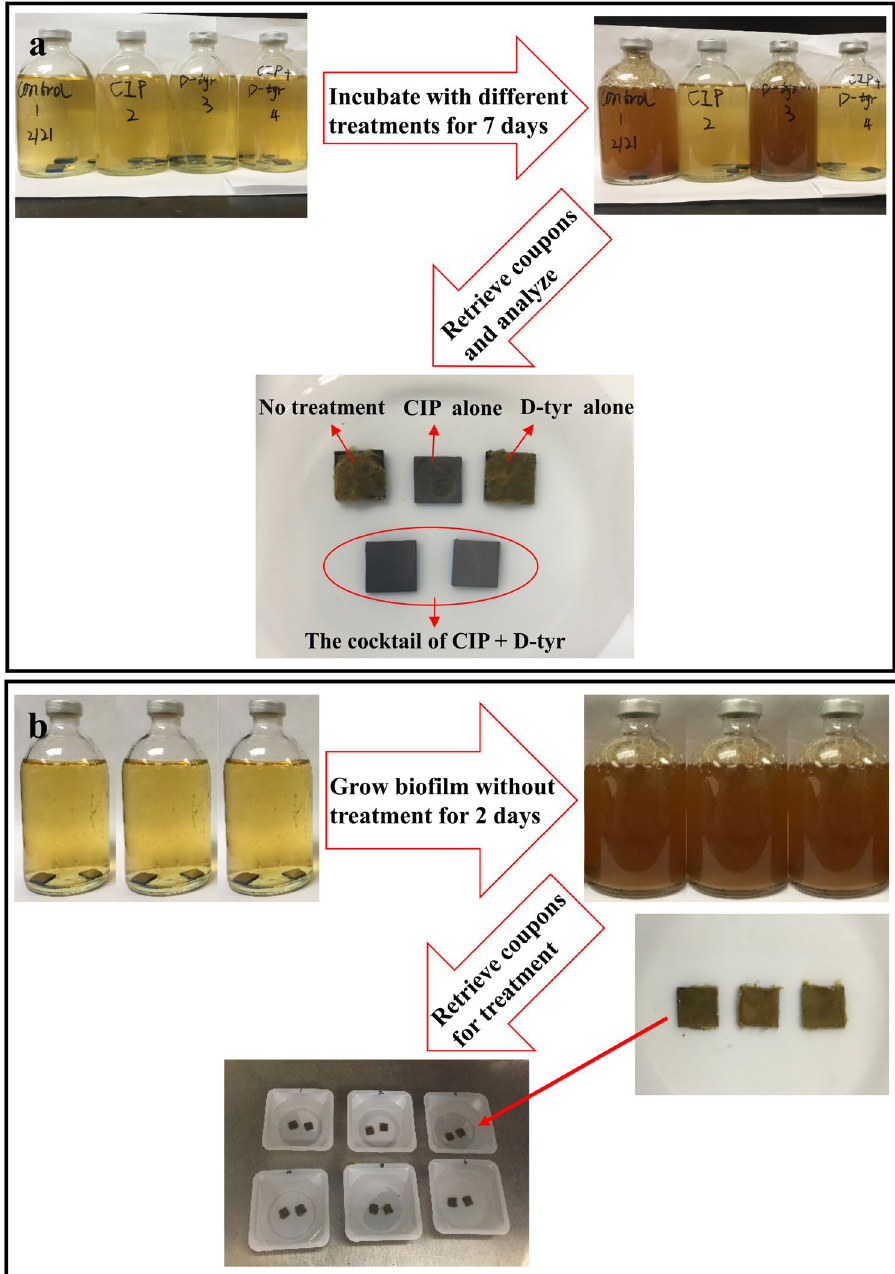
Figure 8. Procedures of the PA biofilm mitigation tests: ( a ) the 7-day biofilm prevention test in anaerobic vials, and ( b ) the 3-hour biofilm removal test in the anaerobic